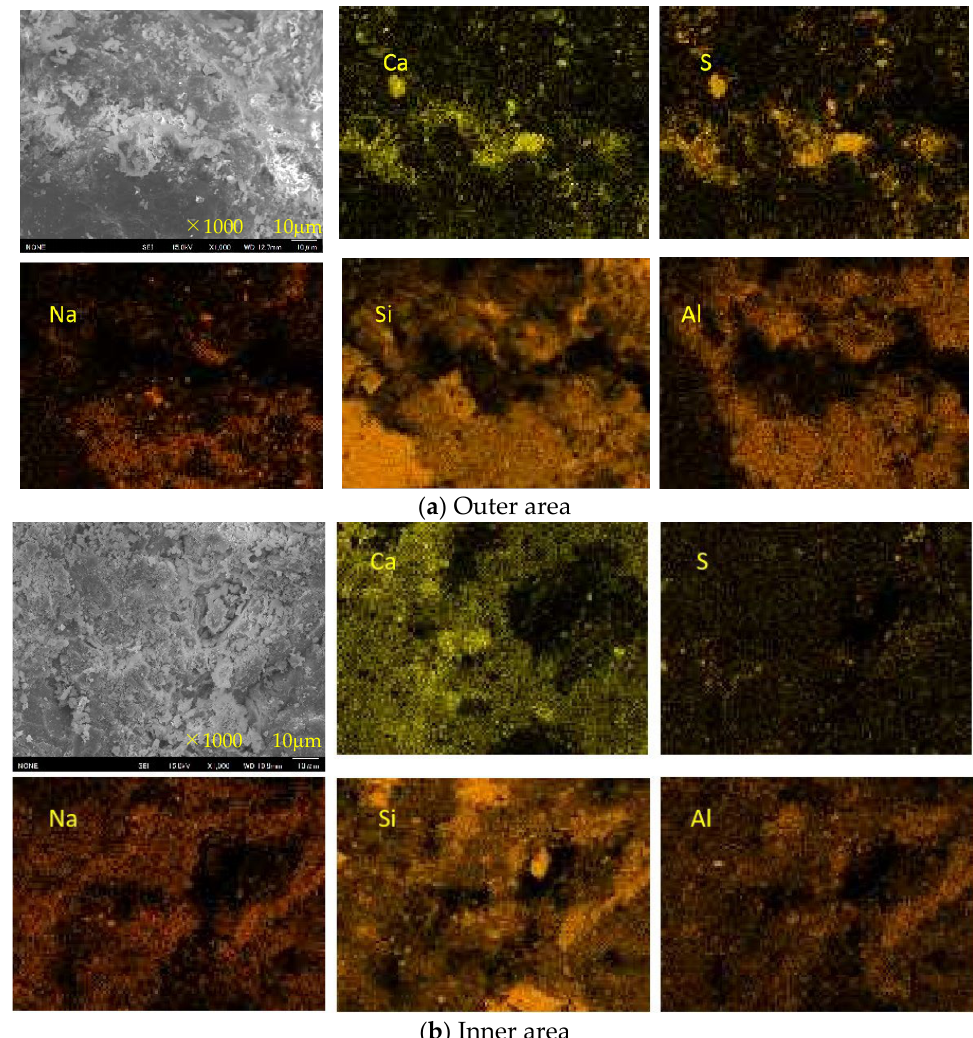
Figure 16. SEM images and element maps of the BFSCSP specimen.